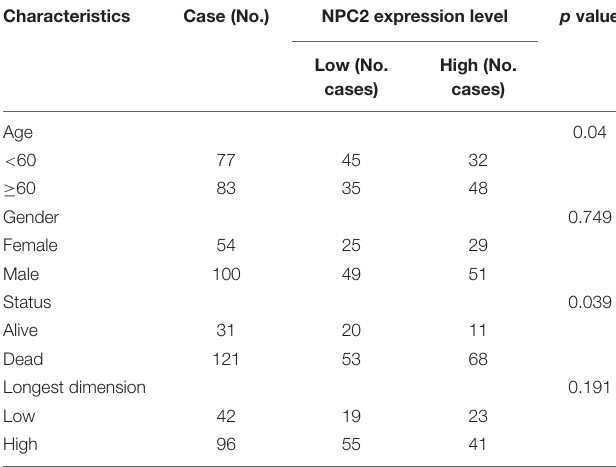
TABLE 1 | NPC2 expression level and clinicopathological factors in 160 GBM patients.